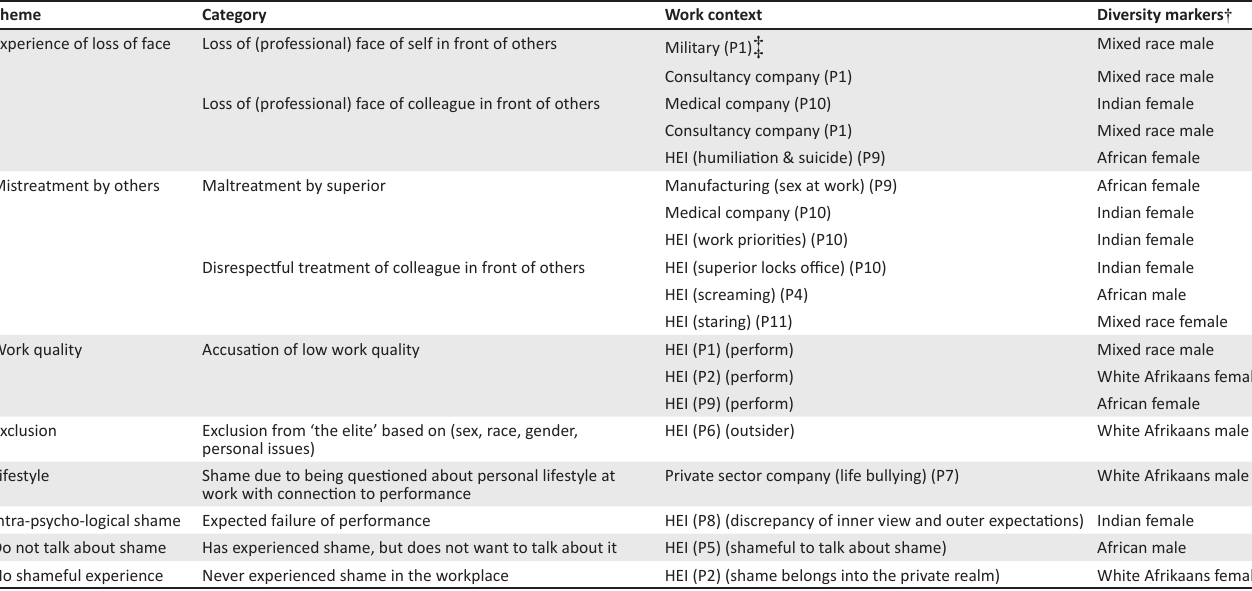
TABLE 2: Shame at the workplace. Theme Category Experience of loss of face